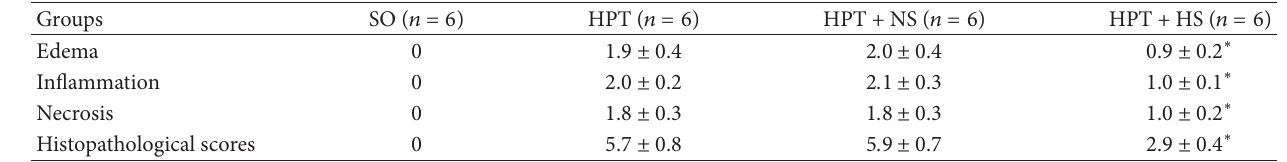
Figure 1: Histopathologic analysis of the pancreas using hematoxylin-eosin staining ( × 200). (a) SO group: pancreatic acini are well conserved without edema, inflammatory infiltrates, or hemorrhage. ((b), (c)) HPT and HPT + NS groups: acute pancreatitis characterized by interacinar edema,inflammatoryinfiltrates,necrosis,andhemorrhage.(d)HPT+HSgroup:thesehistologicalchangesshowedsignificantlylessextensive inflammatory infiltrates, interacinar edema, necrosis, and hemorrhage. Bar equals 50 𝜇 m. Table 1: Histopathological scores of pancreatic